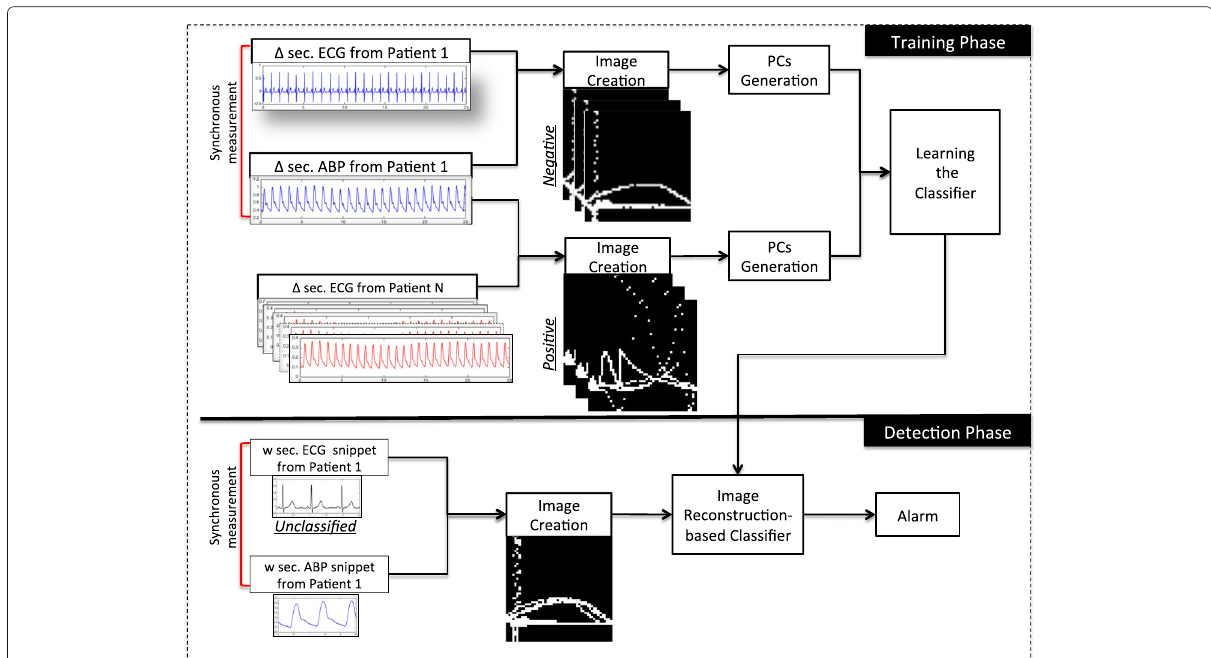
Fig. 5 Detecting malicious alterations of ECG sensor